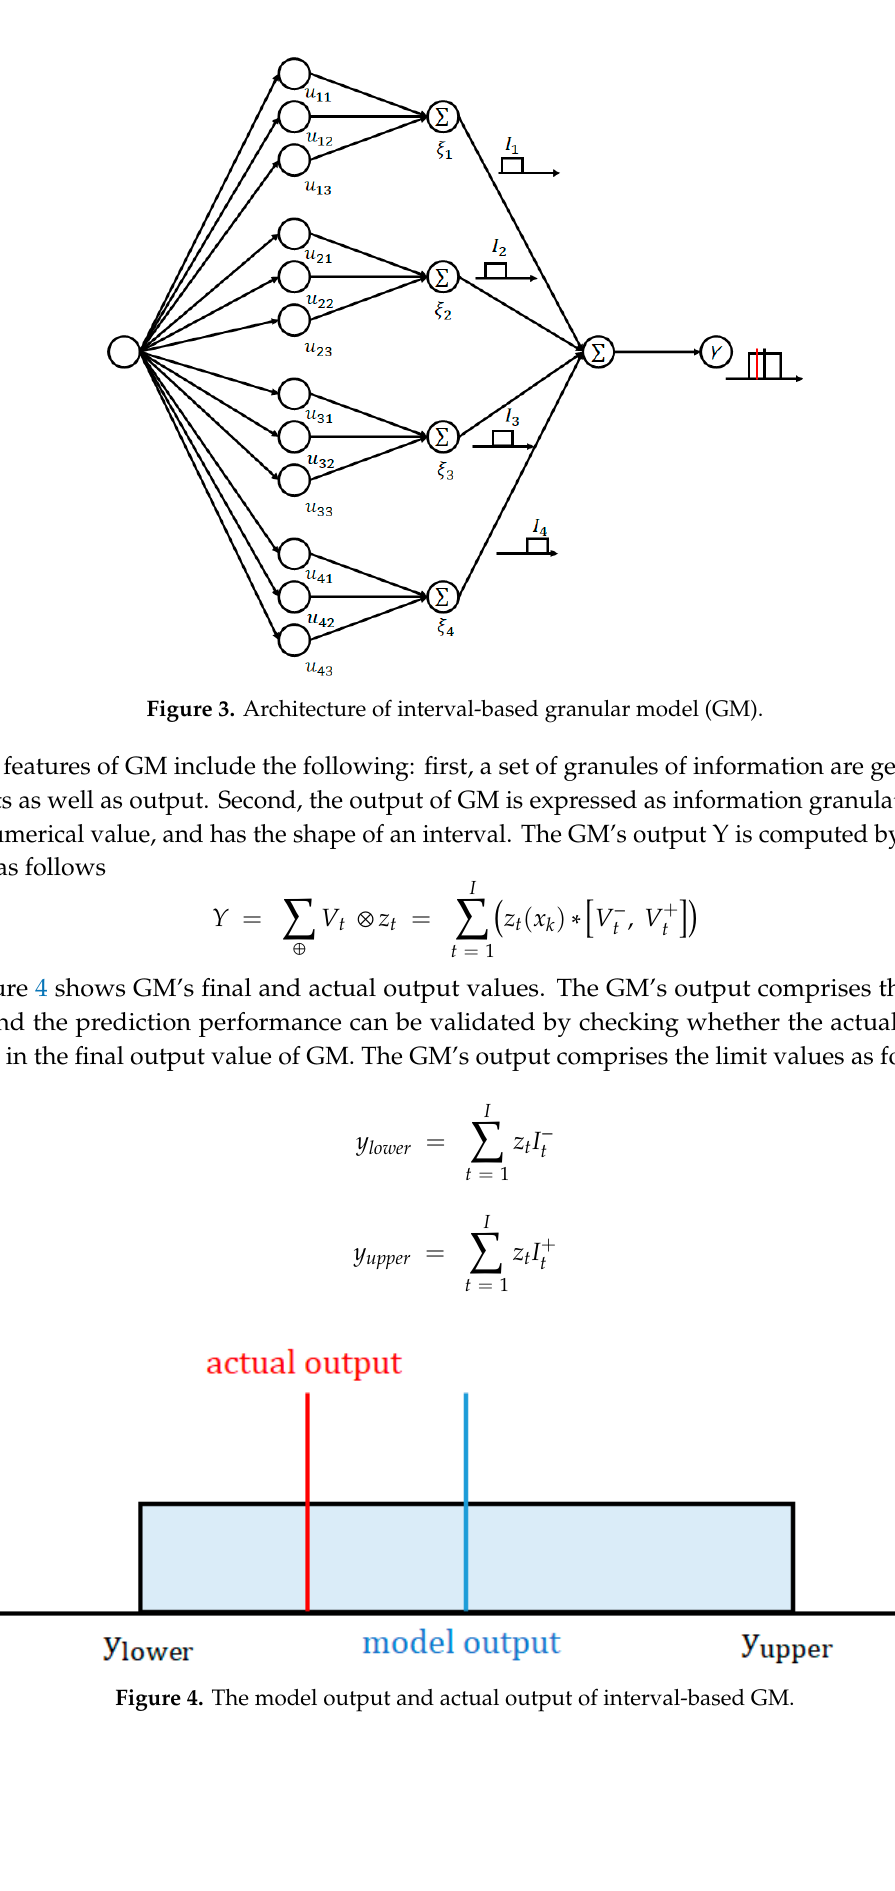
Figure 4. The model output and actual output of interval-based GM.